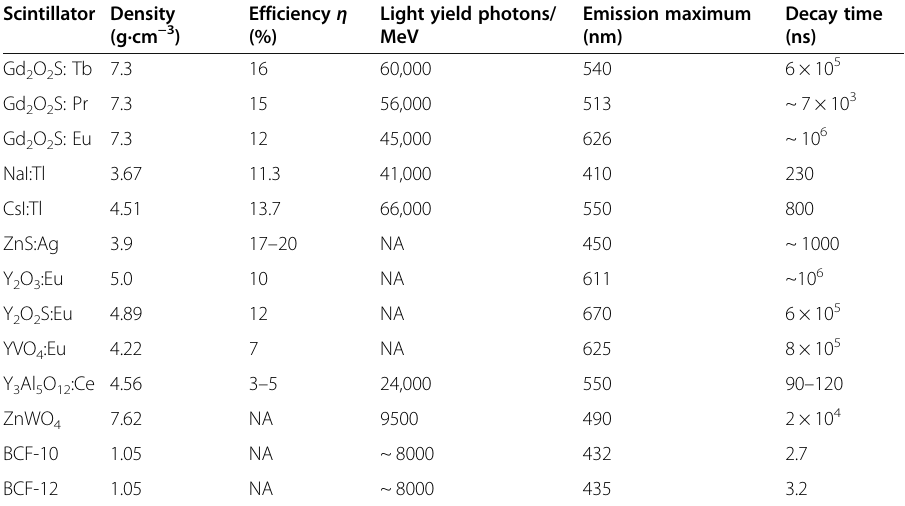
Table 1 The physical properties of typical IOSs compared with OSs BCF-10 and BCF-12 [28, 30, 34, 39 –